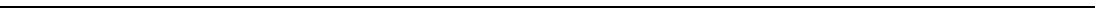
heterogeneity (Fig. 8p-r). Taken together, these in vivo results validated the in silico predictions.